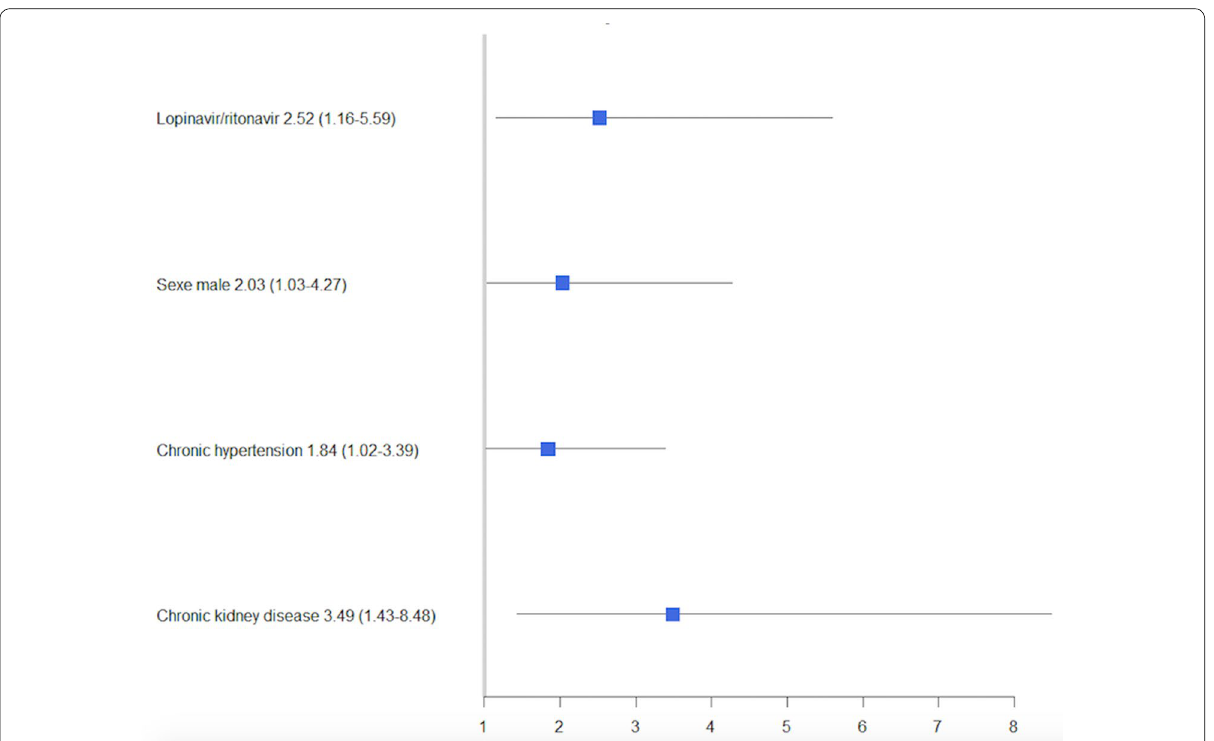
Fig. 2 Forest plot of variables associated with need for RRT. OR (CI95%) were obtained through a generalized linear mixed model including lopinavir, hydroxychloroquine age, sex, BMI, chronic hypertension and moderate‑to‑severe chronic renal failure with center as random effect ( N 410). RRT renal replacement therapy. Chronic kidney disease: moderate‑to‑severe chronic renal =